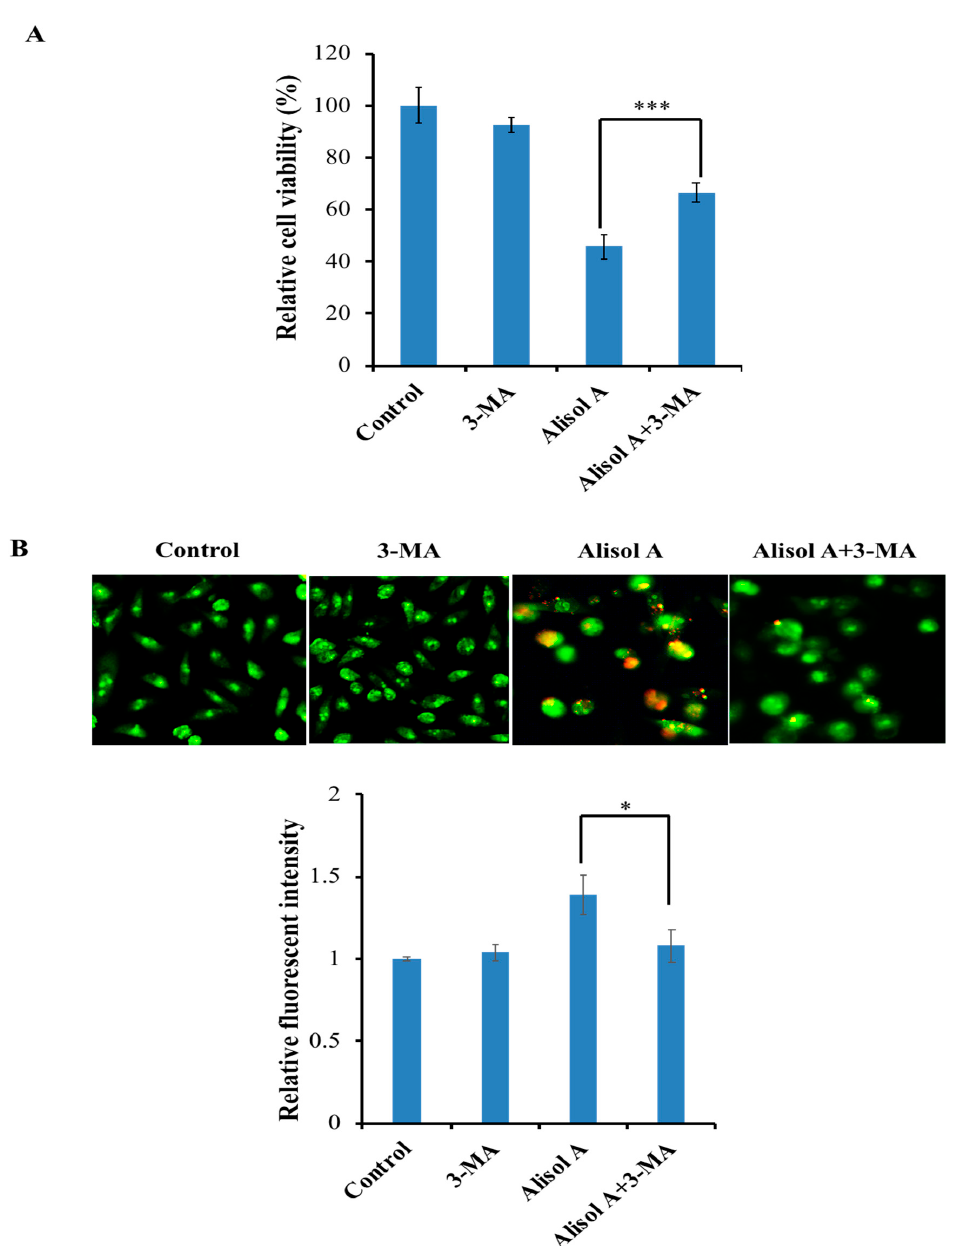
Figure 4. Effects of 3 ‐ MA on alisol A ‐ induced autophagy. ( A ) Autophagy inhibitor 3 ‐ MA reversed